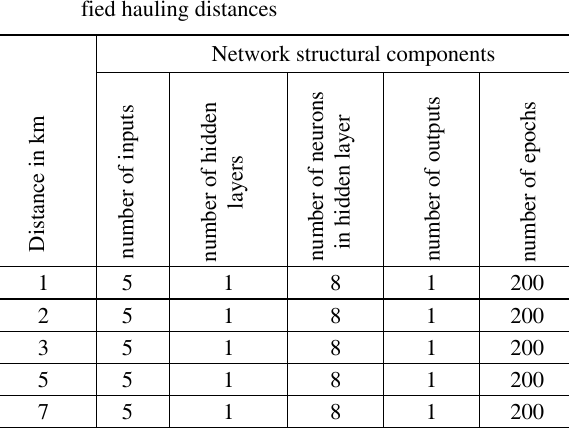
Fig 4 . Structure of adopted unidirectional multilayer error backpropagation network with a conjugate gradient algo- rithm (BPNN-CGB)